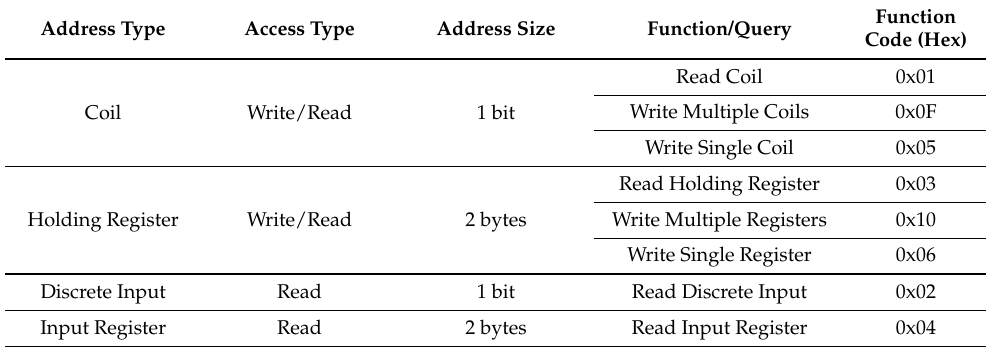
Table 10. Selected modbus function